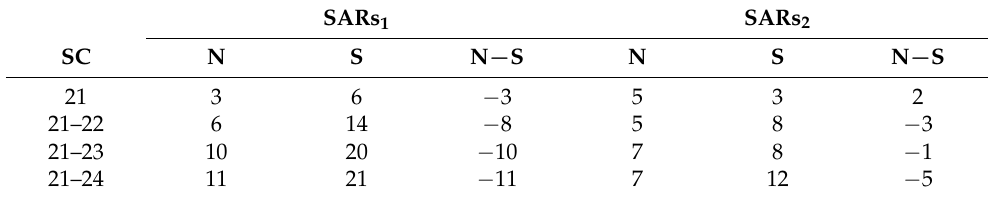
Table 4. The cumulative number of SARs 1 and SARs 2 during SCs 21–24 SARs 1 SARs